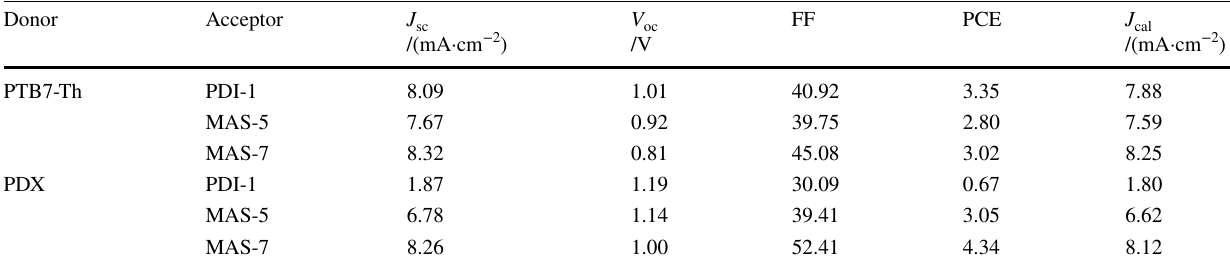
Table 2 Key parameters of OSCs based on PTB7-Th/PDX: